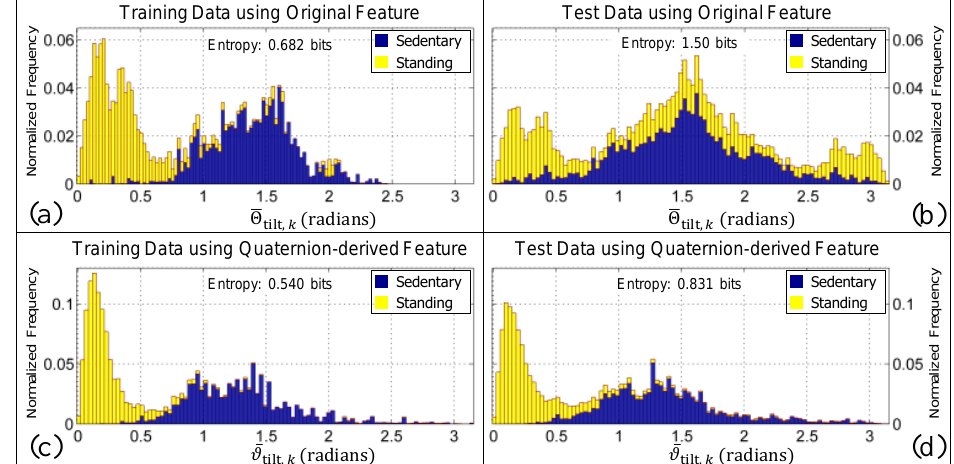
Figure 7. The normalized histograms of the sedentary and standing classes (illustrated in Figure 4) for the features ¯ Θ tilt, k and ¯ ϑ tilt, k . Panels ( a , c ) are the histograms obtained when the training data are used (i.e., the pooled data from the younger and older cohorts, respectively). Panels ( b , d ) are the histograms obtained when the test data are used (i.e., the pooled data from the younger and older cohort after it had been virtually re-oriented using each of the quaternions in Figure 1b–f). The bar charts in all panels are ‘stacked’. Note that the entropy for the quaternion-derived feature is consistently smaller, which suggests that it will be better at distinguishing between activity